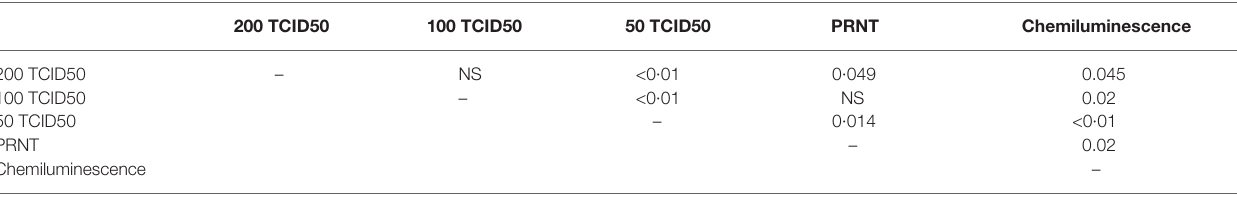
TABLE 2 | p values of Wilcoxon Sum Rank Test comparisons of various assays.